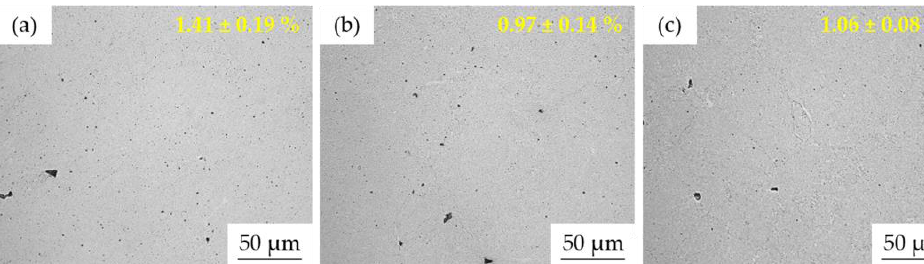
Figure 5. SEM + EDS map of element distribution in Mn10Al10 MA powder alloy.